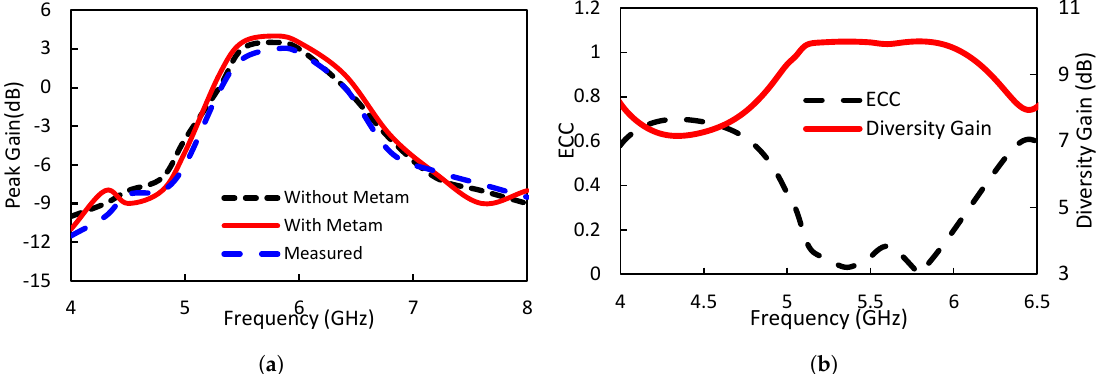
Figure 9. ( a ) Peak Gain of the proposed MIMO antenna, ( b ) ECC and Diversity Gain of the proposed